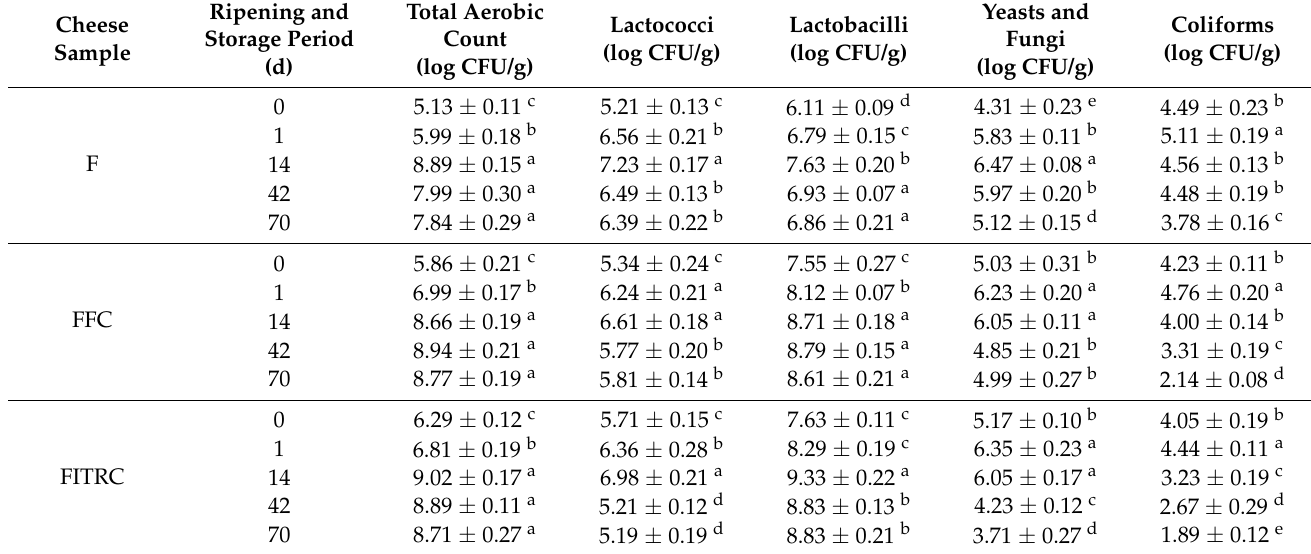
Different superscript letters in a column indicates statistically significant differences (ANOVA, Tukey’s HSD multiple range test, p < 0.05). F = White brined cheese with no starter culture, FFC = White brined cheese produced with free L. paracasei SP5, FITRC = White brined cheese produced with immobilized L. paracasei SP5 on